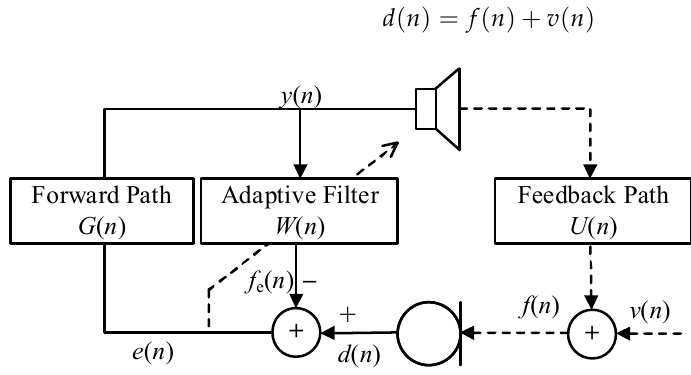
Figure 1. Schematic of AF-based acoustic feedback cancellation. The acoustic feedback path U ( n ) is modeled by the AF W ( n ) , and the degree of deviation between W ( n ) and U ( n ) is called misalignment (MIS). When the MIS is small, f e ( n ) , the output signal of W ( n ) , is approximately equal to f ( n )